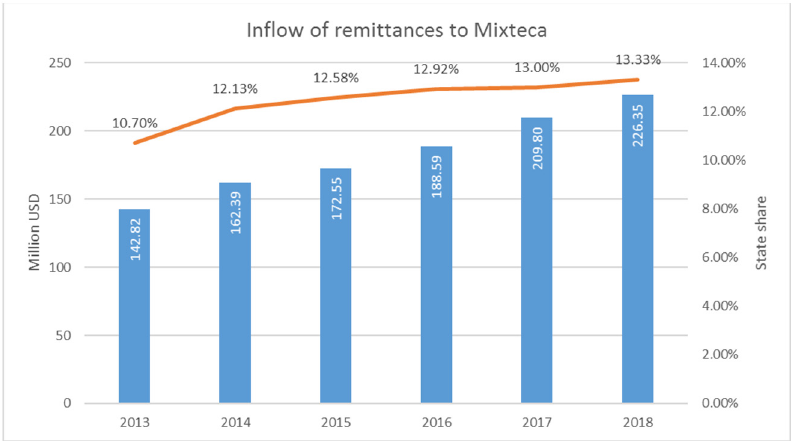
Figure 3. Inflow of remittances to Mixteca and share of state participation, authors own calculations based on data from [53].